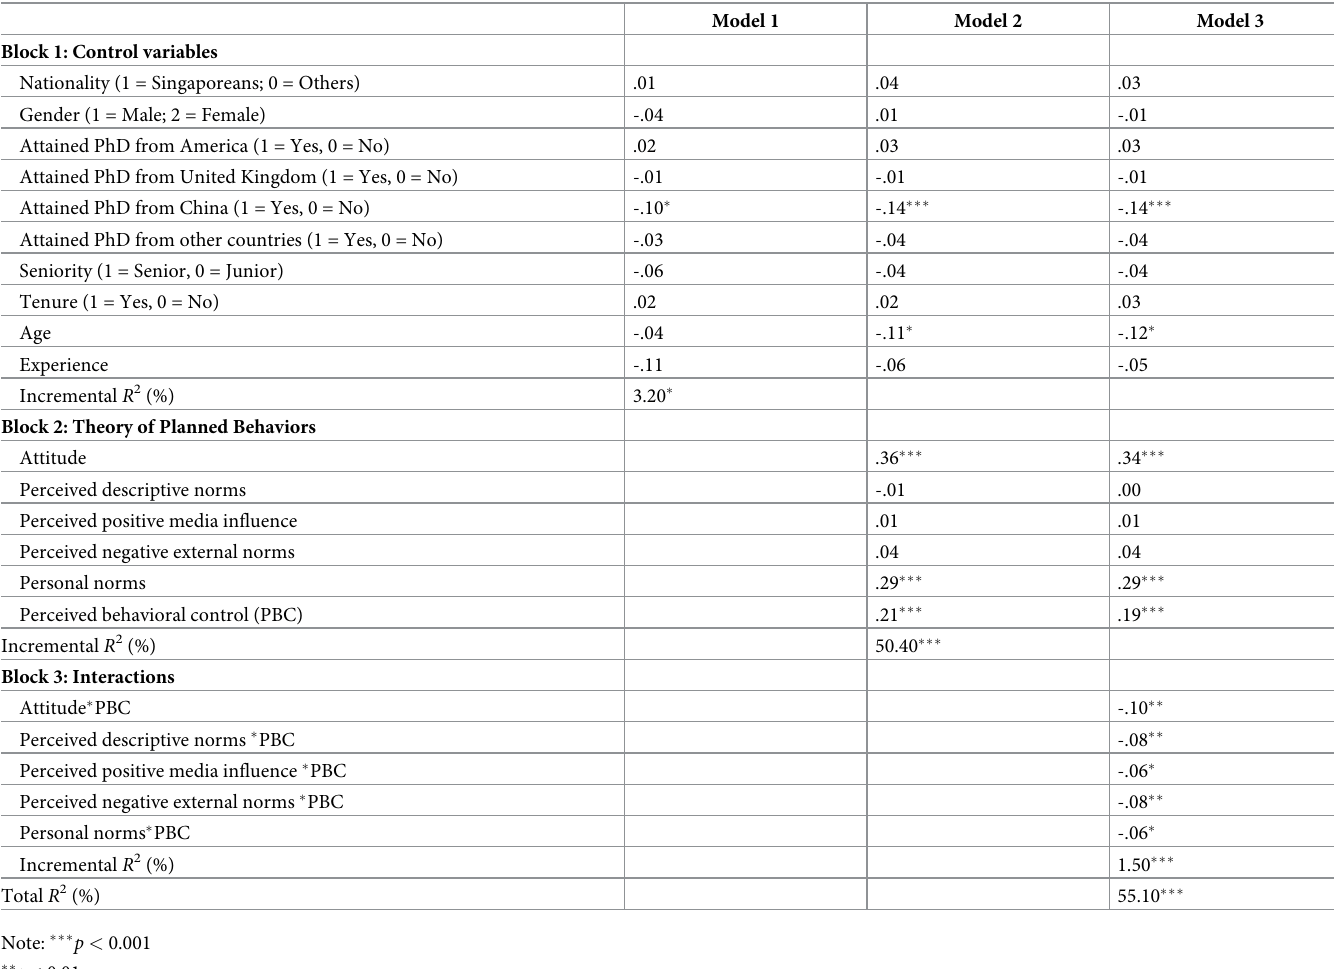
Table 1. Factors predicting scientists’ willingness to conduct public